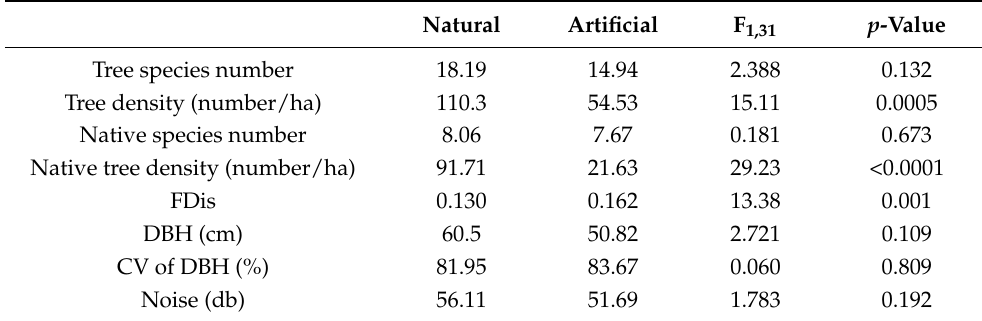
Figure 2. Total counts of tree species individuals in artificial (orange) and natural (green) sections, with color of species names indicating status (green: native; red: cultivated; blue: cultivated/naturalized; black: unknown). Table 1. Comparisons of following habitat characteristics of natural and artificial sections: means of number of tree species, tree density, number of native species, native tree density, tree functional dispersion (FDis), diameter at breast height (DBH), coefficient of variation (CV of DBH), noise, and variance analysis (F 1,31 and p